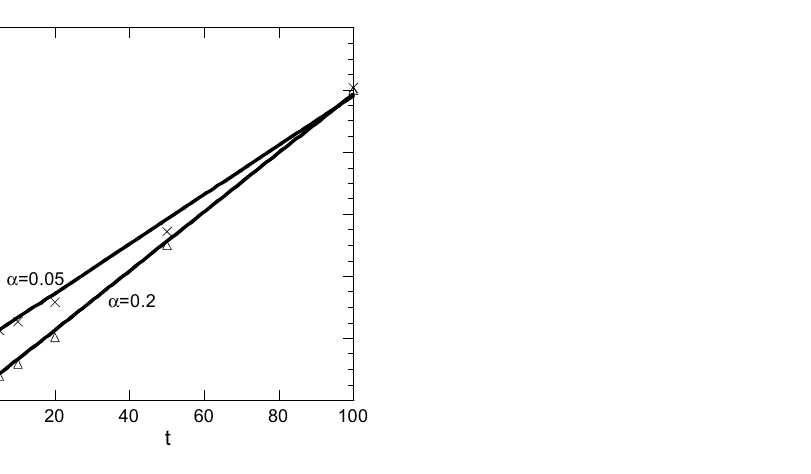
Figure 2. Example 1: Pseudo-second order linear fits (continuous lines) to pseudo-first order data (symbols) for α = 0.05 and α = 0.2.